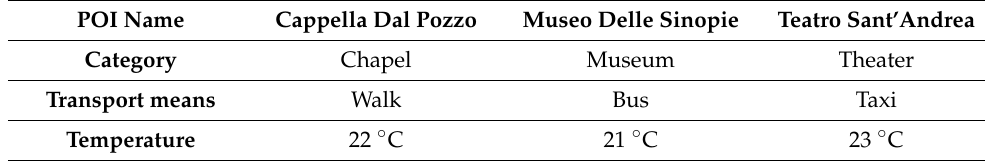
Table 1. Example of user semantic